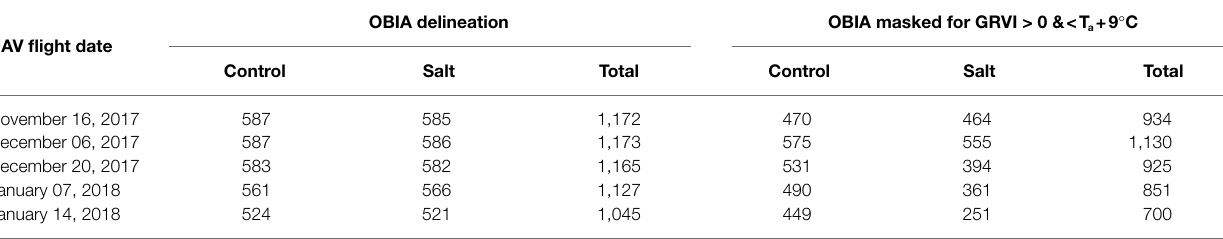
TABLE 3 | Number of plants for which plant temperature (T p ) was retrieved in each of the thermal infrared